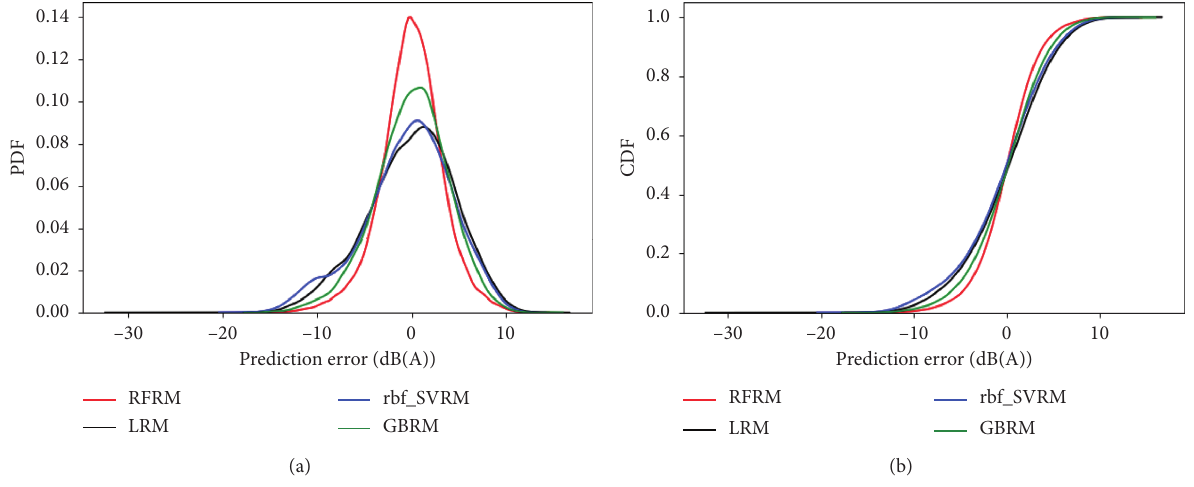
Figure 5: Comparison of the prediction error